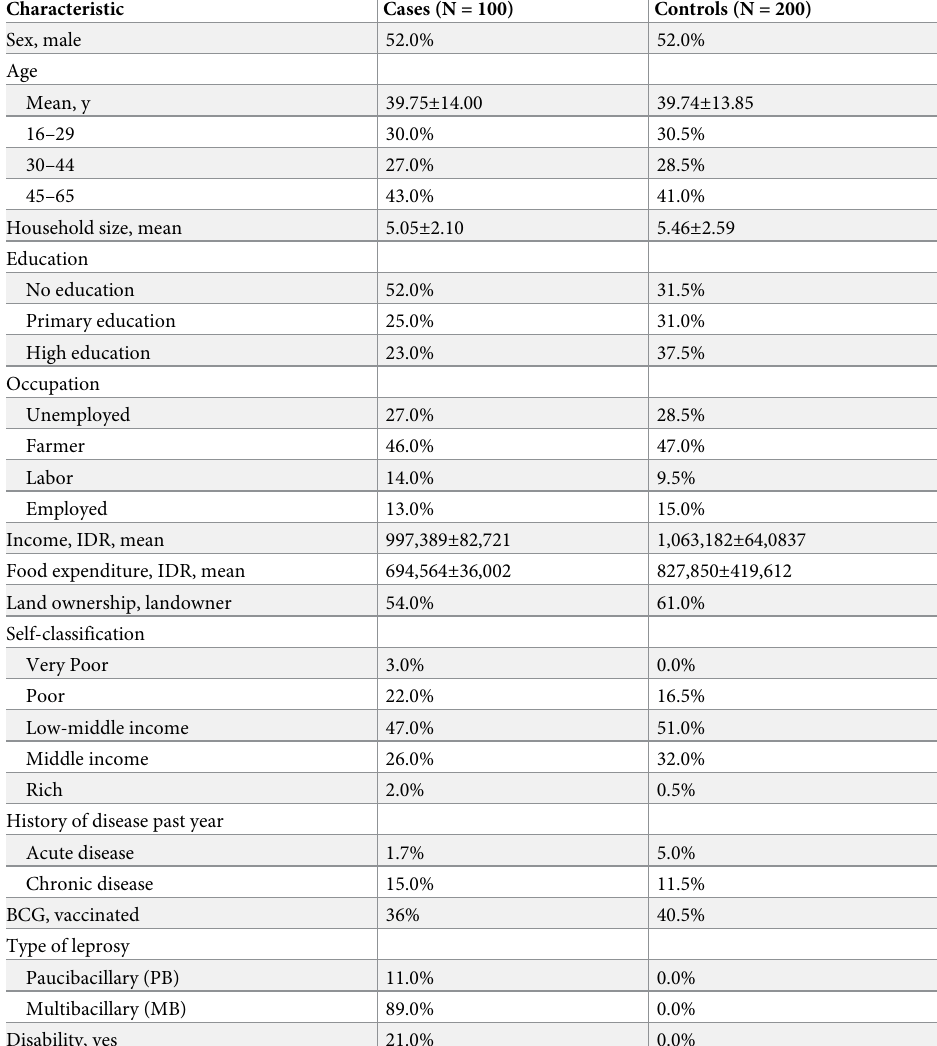
Table 1. Demographic, socioeconomic, and health